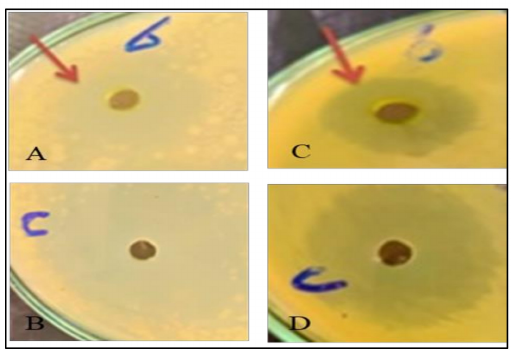
Figure 2. E ff ect of CHT 200 mg / L on di ff erent bacterial activity of Solidago canadensis cv. Tara plant. ( A , B ): E ff ect of CHT 200 mg / L on P. fluorescens. ( C , D ): E ff ect of CHT 200 mg / L on Bacillus